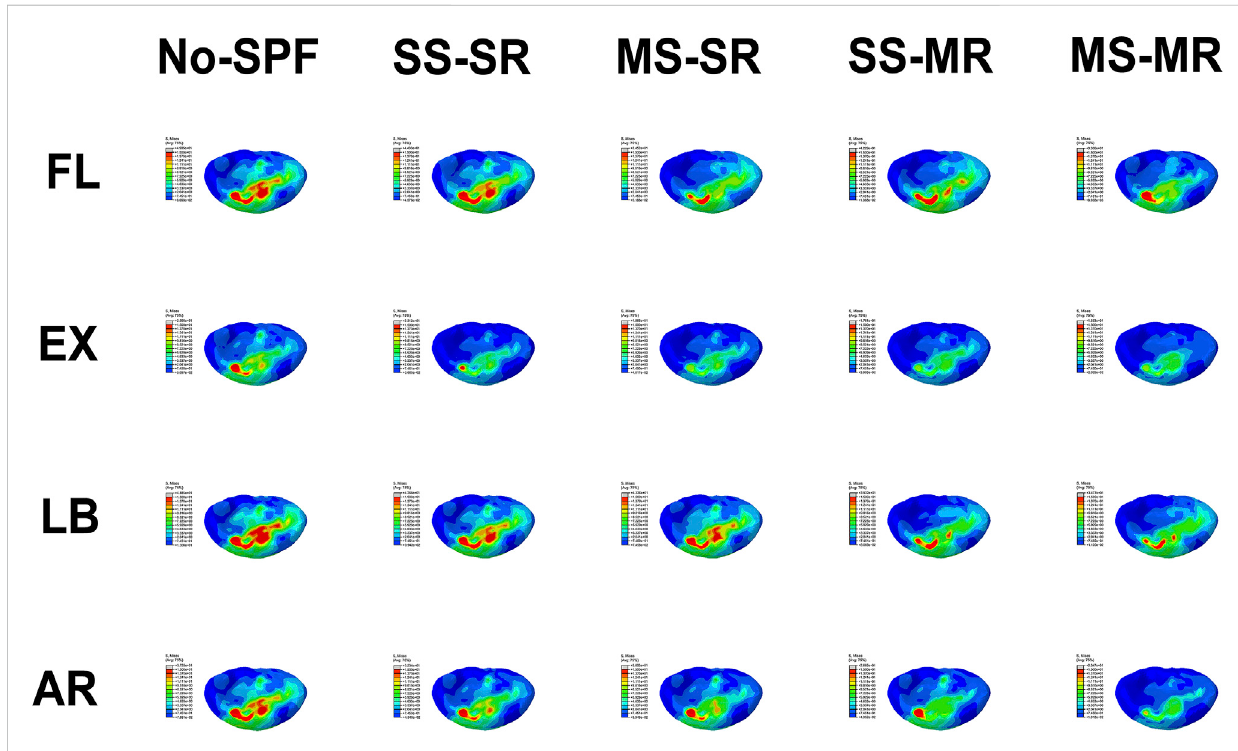
FIGURE 8 Von-Mises stress on S1-superior endplate of different instrumented models in fl exion, extension, lateral bending, and axial